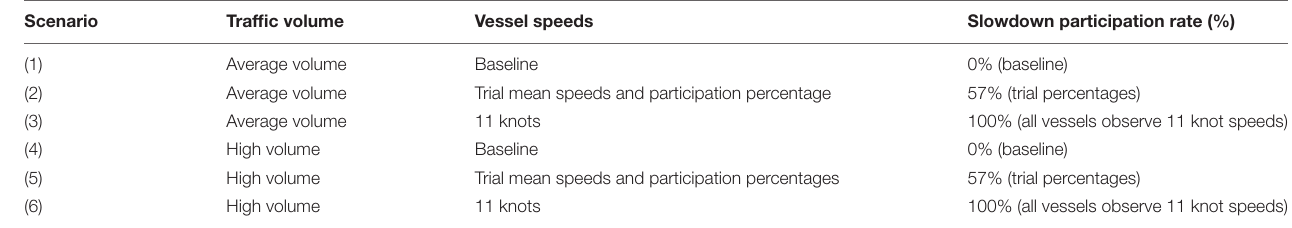
TABLE 2 | Six Modeling Scenarios described by the regional vessel noise models.